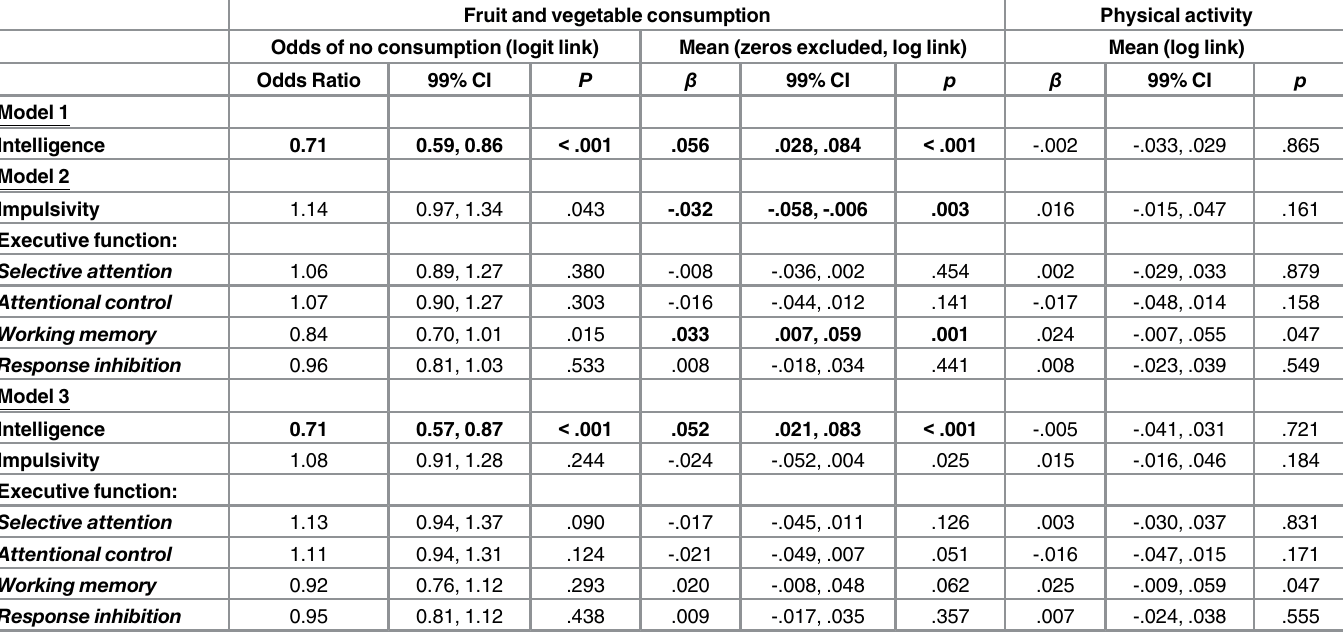
Table 7. Gamma regressions predicting fruit and vegetable consumption and moderate-vigorous physical activity at age 13. Fruit and vegetable